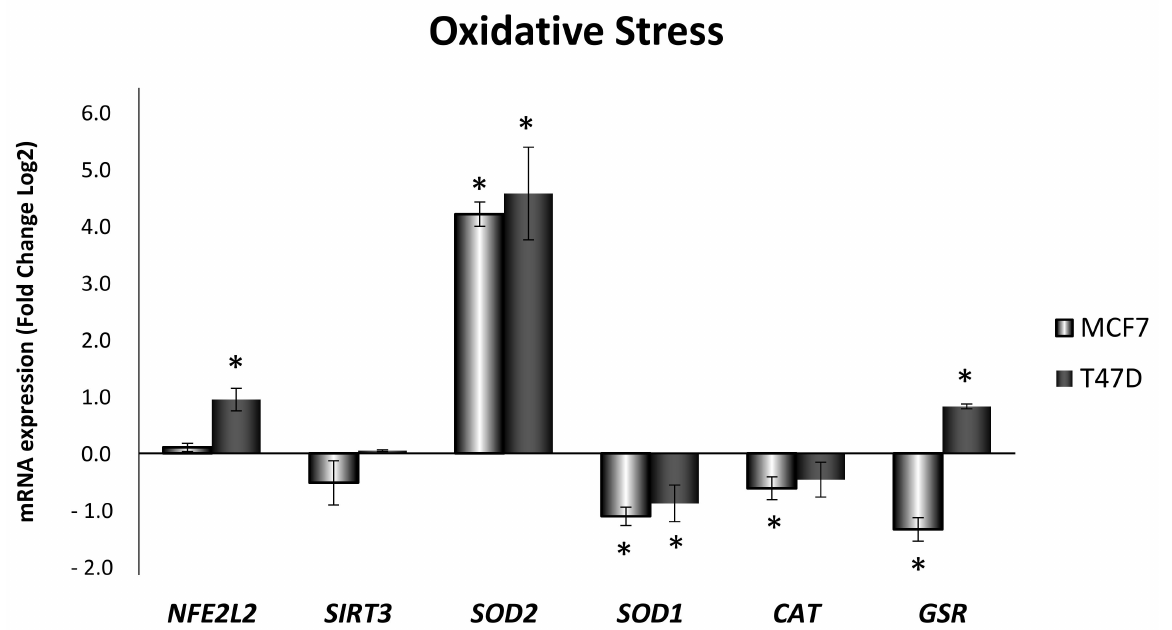
Figure 2. Obesity-related inflammation treatment modified expression of genes related to oxidative stress in MCF7 and T47D breast cancer cell lines. NFE2L2 : nuclear factor erythroid 2-related factor 2; SIRT3 : sirtuin 3; SOD2 : manganese superoxide dismutase; SOD1 : copper/zinc superoxide dismutase; CAT : catalase; GSR : glutathione reductase. Breast cancer cells were incubated for 24 h with vehicle (DMSO) or ELIT. Data are represented as fold change (log2) of mRNA expression with respect to vehicle-treated cells, set at 0, of each cell line. Data represent means ± SEM ( n = 6). * Statistically significant difference between treated and vehicle-treated cells (Student’s t -test, p <